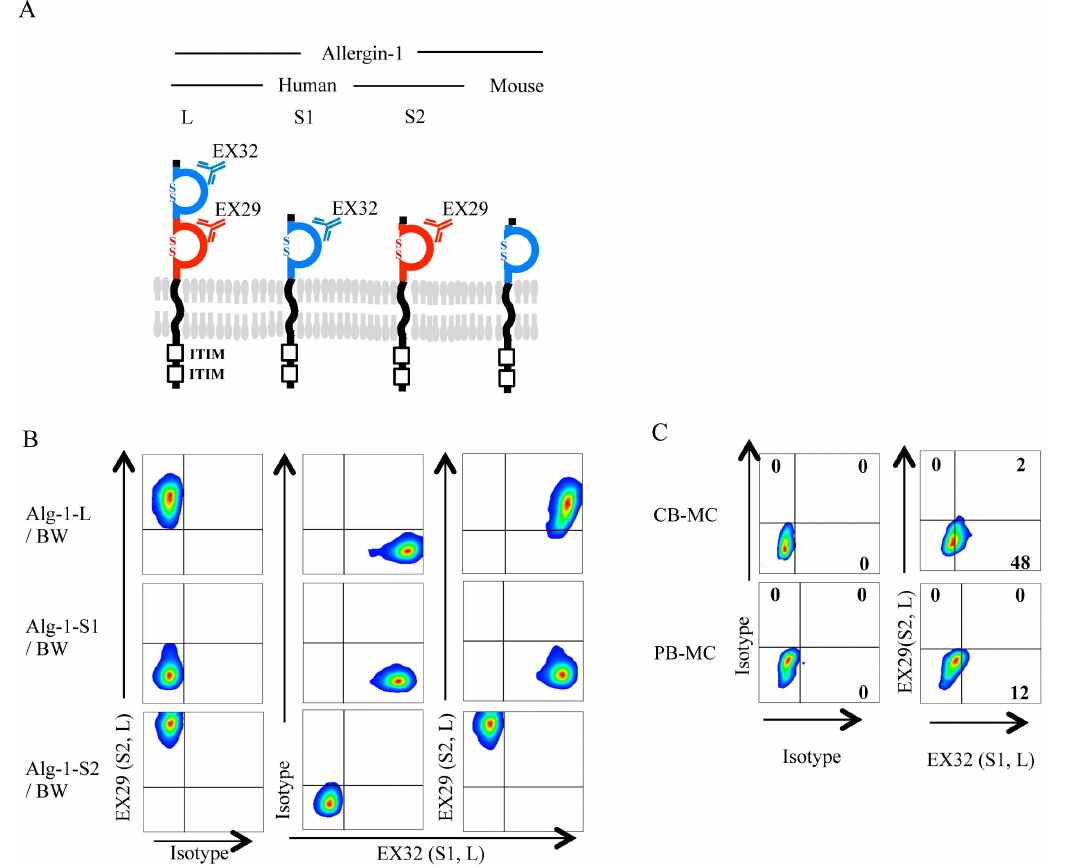
Figure 2. Expression of Allergin-1 isoforms on CB-MC and PB-MC. A. Structure of human and mouse Allergin-1. Unlike mouse Allergin-1, human Allergin-1 consists of three splice isoforms, Allergin-1L, Allergin-1S1, and Allergin-1S2. The first and second immunoglobulin-like domains in the extracellular portion of Allergin-1L is identical to that of Allergin-1S1 and Allergin-1S2, respectively. B. BW5147 transfectants stably expressing each isoform of Allergin-1 were stained with isotype control, anti-Allergin-1S1-specific EX32, and/or anti-Allergin-1S2-specific EX29 mAbs and were analyzed by using flow cytometry. C. CB-MC and PB-MC were stained with isotype control Abs or with EX32 and EX29 mAbs and were analyzed by using flow